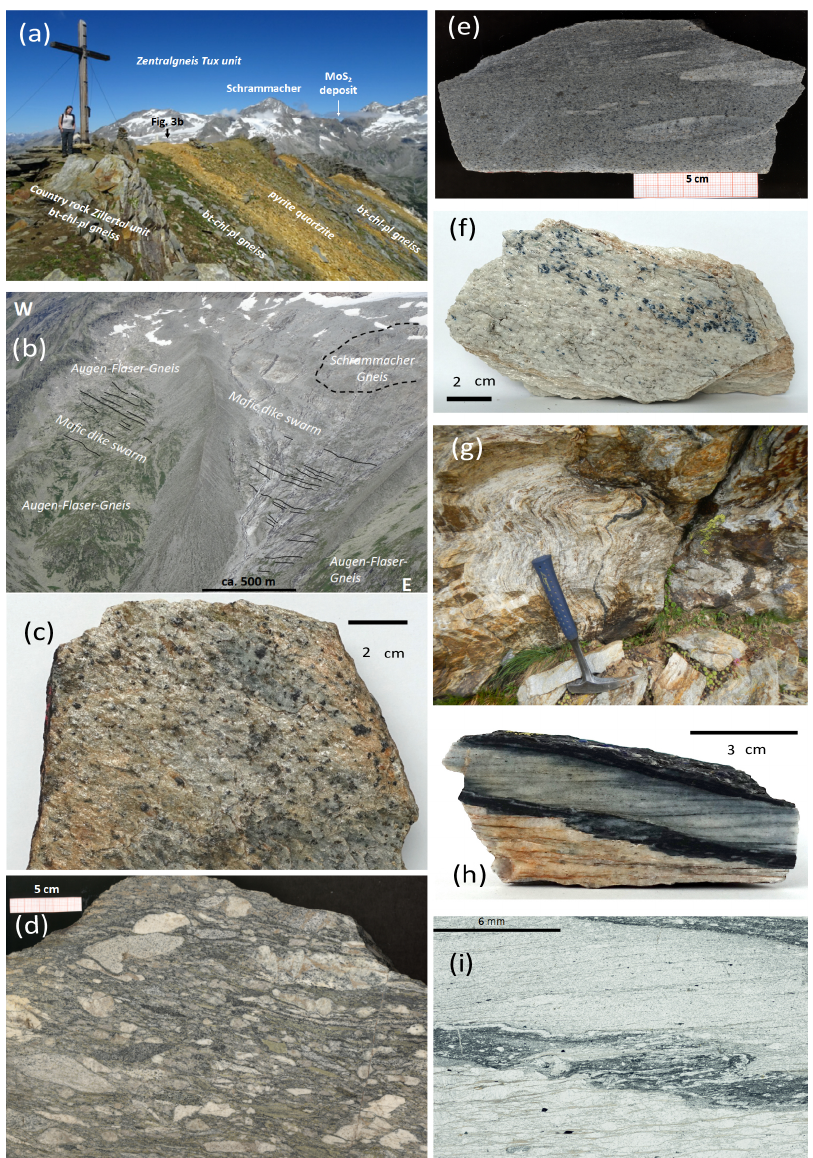
Figure 3. Field photographs and hand specimen and thin-section images of representative rocks. (a) View at top of Rotbachlspitze, showing in the foreground the basement of the Pfitsch–Mörchner basin, the Zillertal unit country rock (biotite–chlorite–plagioclase gneiss), interlayered with weathered reddish pyrite quartzite. The background shows the peaks of the Zentralgneis from the Tux unit, with the Schrammacher peak and to its right the locality of the molybdenite deposit of the Alpeinerscharte. Location of the figure (b) with the mafic dike swarm is indicated. (b) View from the crest of the Rotbachlspitze towards the lower part of the Tux Zentralgneis, with the mafic dike swarm (outlined) between and left of the two moraine walls of the Schrammacher glacier. (c) Hand specimen of magnetite–chloritoid–staurolite–chlorite lens; sample is 12cm wide. The specimen is similar to sample H in Barrientos and Selverstone (1993). (d) Cut slice of metaconglomerate, the base of the Mesozoic Pfitsch–Mörchner basin. Note partly angular, partly rounded pebble components (for more details, see text). (e) Cut and polished slice of tourmaline gneiss with light, lens-shaped, feldspar-rich aggregates, interpreted as deformed pebbles of a conglomeratic precursor (for more photos see Supplement 4.3.8 in Franz et al., 2021) (f) Hand specimen of lazulite quartzite, the top of the Pfitsch– Mörchner Formation, view onto the foliation plane; size of the sample’s longest dimension is 16cm. Light blue patches are aggregates of lazulite with other phosphate minerals (for details, see text). (g) Field photograph of strongly deformed and folded metaconglomerate, with a thin tourmalinite vein (upper right of hammer handle). (h) Cut and polished slice of tourmalinite vein in the lazulite quartzite. Foliation is horizontal; the vein is slightly discordant to the weathered yellowish quartzite. Note the bimodal character of the tourmalinite, with an upper and lower domain rich in tourmaline and a quartz-rich central domain; for more photos of crosscutting relations see Supplement 4.3.6 in Franz et al. (2021) and Henry et al. (2002). (i) Thin-section micrograph of hand specimen (plane-polarized light), shown in (g) , showing the central fine-grained and quartz-rich domain (upper part), followed by the tourmaline-rich domain. The lower part is the conglomeratic quartzite country